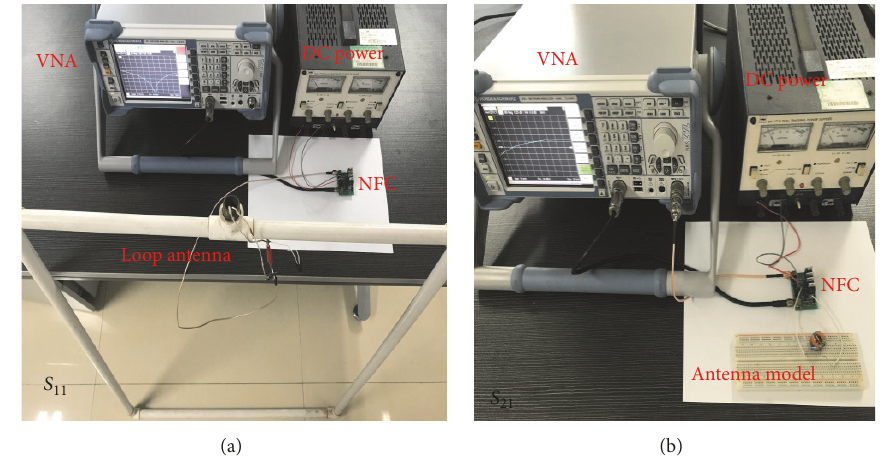
Figure 10: (a) 𝑆 11 of NFC matching experiment setup. (b) 𝑆 21 of NFC matching experiment